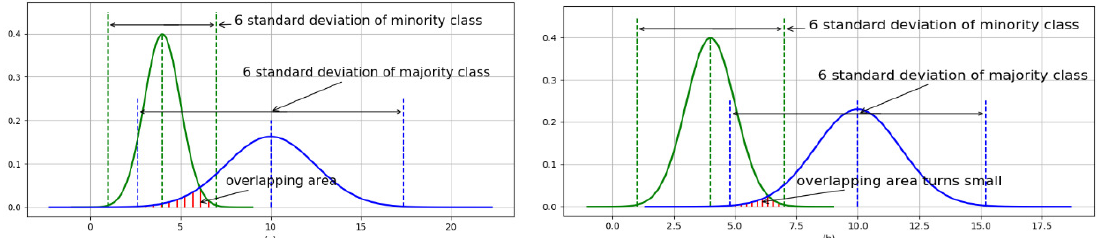
Figure 2. Distribution of overlapping area. ( a ) Distribution of original dataset in one dimension; ( b ) Removing less informative samples in